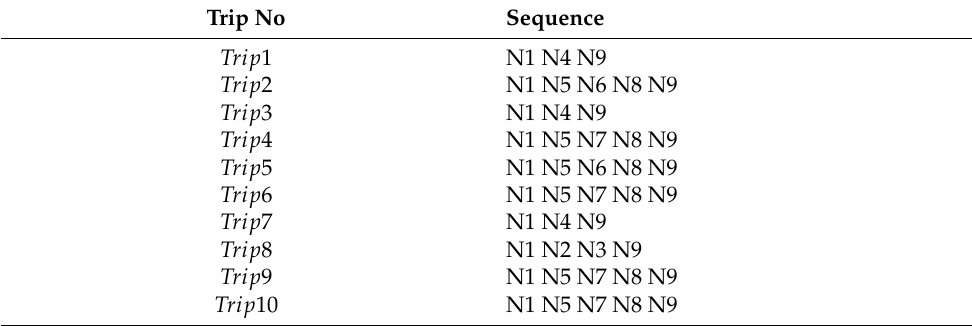
Table 2. Rideshare trips